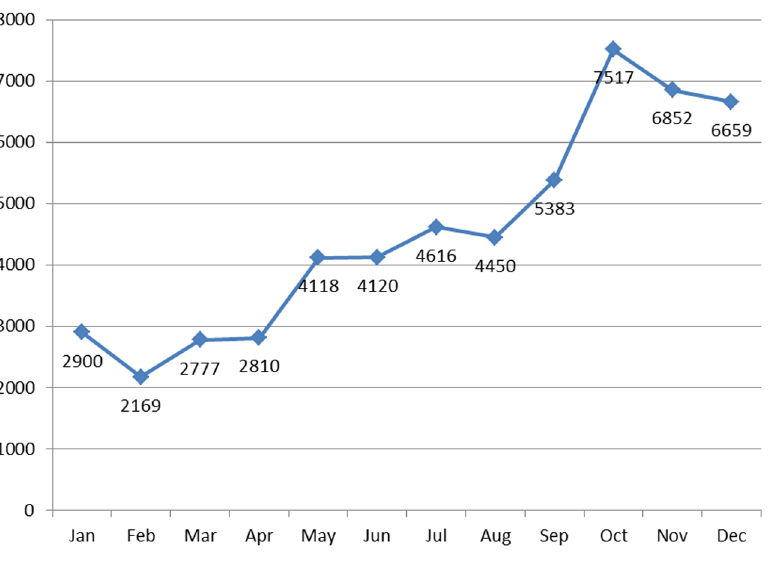
Figure 1. Number of article downloads per month in